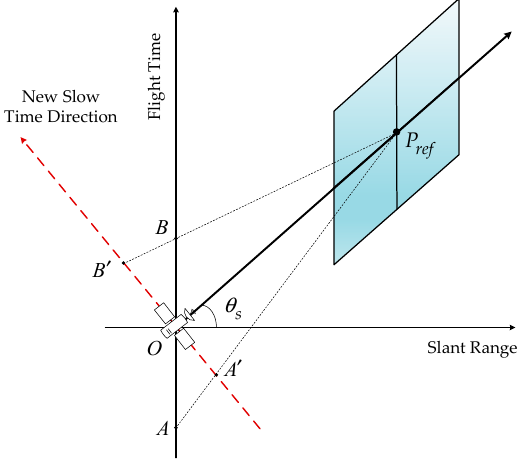
Figure 8. Equivalence between the broadside mode and the squint mode for a reference target P ref using a variable starting time for the receive window.